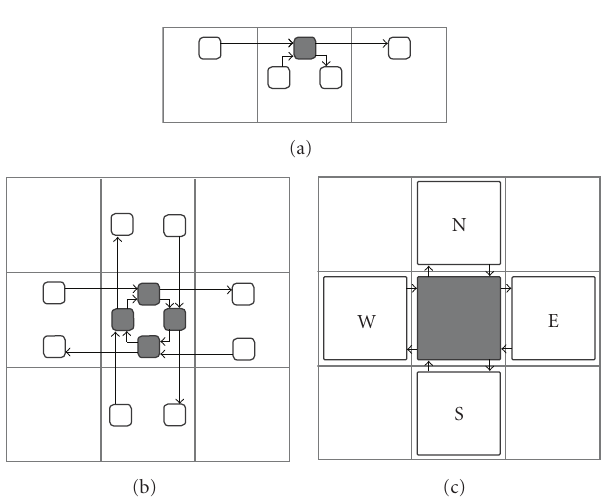
Figure 1: Where pulses are received from and sent to by (a) a quarter, (b) the four quarters of a cell, and (c) a cell. Each arrow represents a pair of wires.